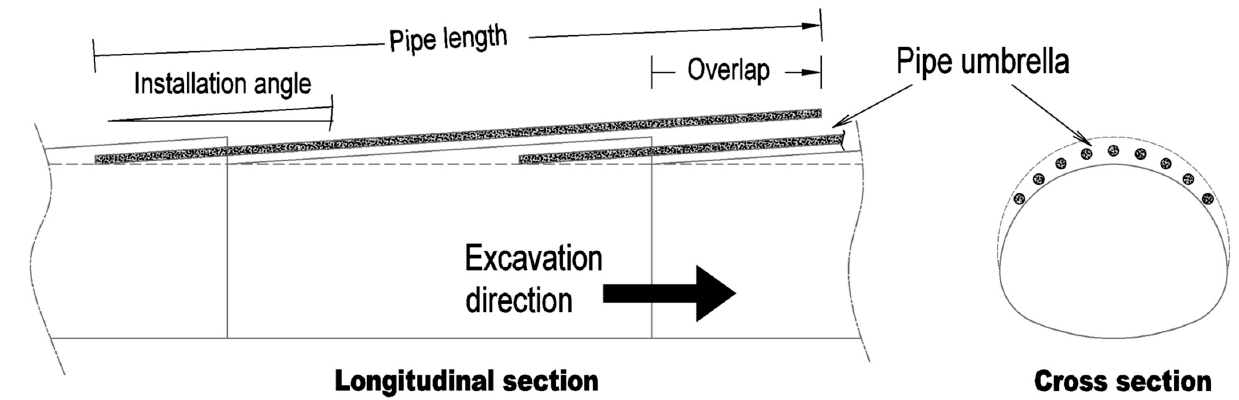
Figure 1. Cross section and longitudinal profil of an umbrella arch technique.